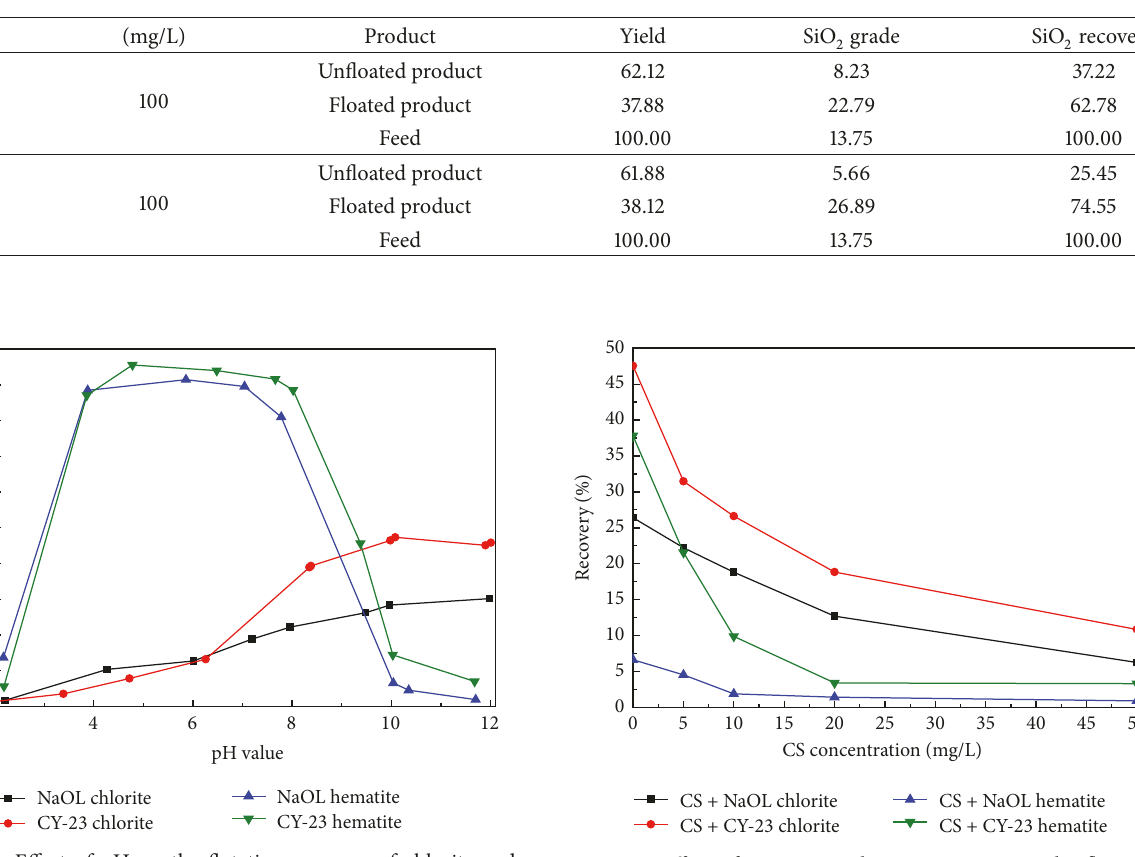
Figure 3: Effect of caustic starch concentration on the flotation recovery of chlorite and hematite { pH = 10, 𝑐 (NaOL, CY-23) = 50 mg/L }